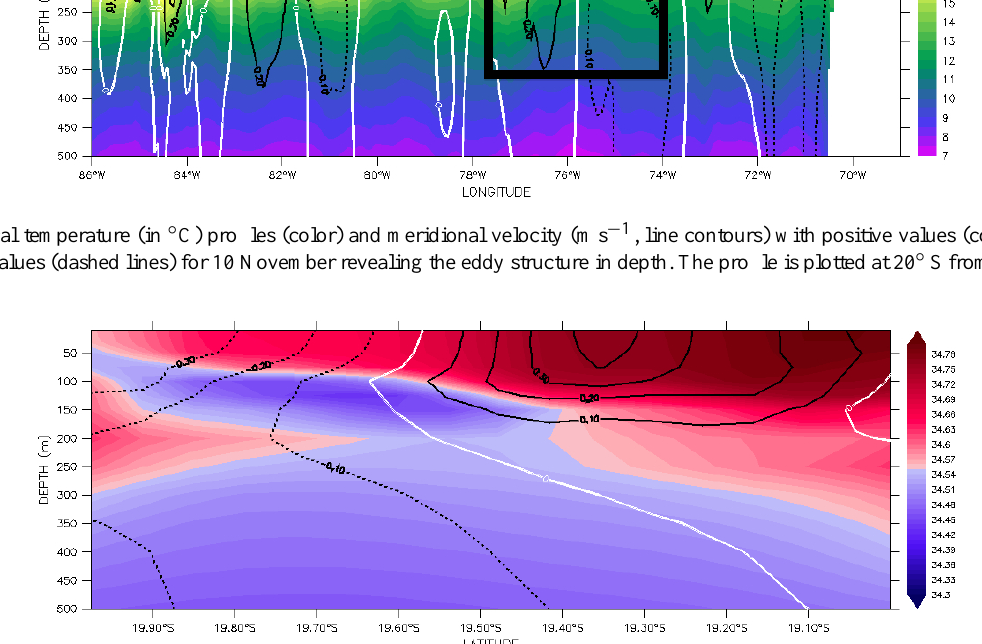
Fig. 13: Vertical temperature (in ◦ C) profiles (color) and meridional velocity (m s − 1 , line contours) with positive values (continuous lines) and negative values (dashed lines) for 10 November revealing the eddy structure in depth. The profile is plotted at 20 ◦ S from 86 ◦ W to 69 ◦ W